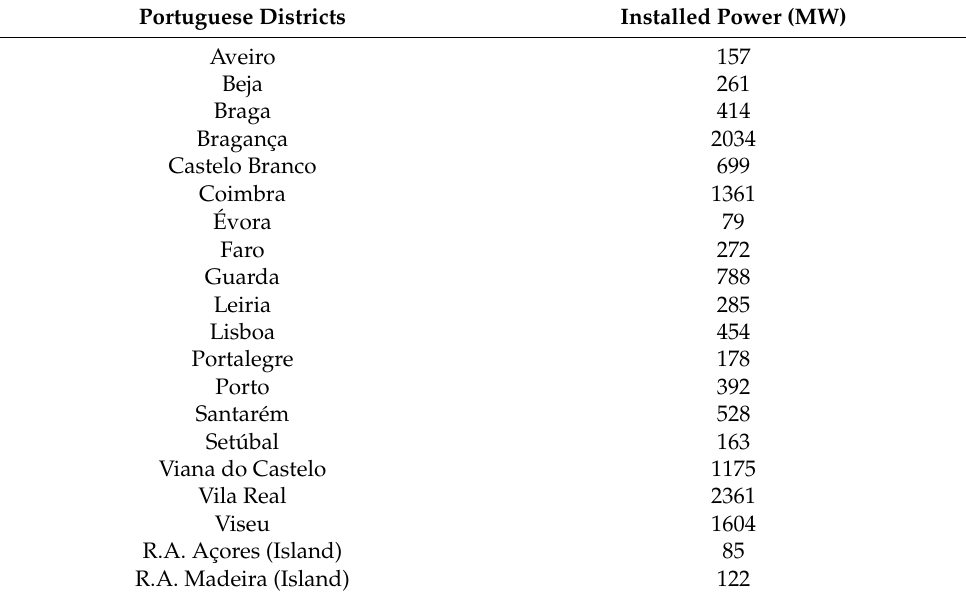
Table 7. Renewable power in Portugal by district [62].